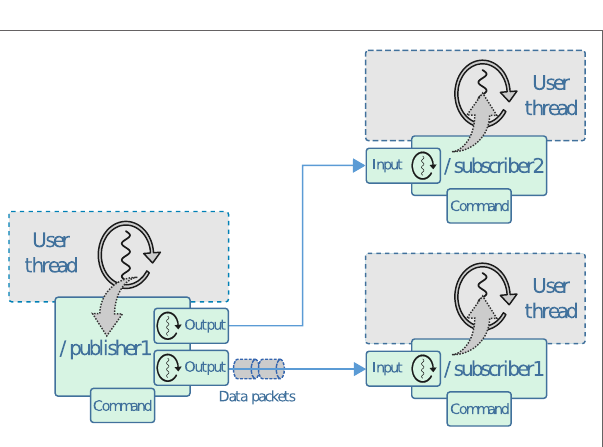
FigUre 4 | an example of components asynchronous communication in YarP . A publisher is pushing messages to two different subscribers using separate